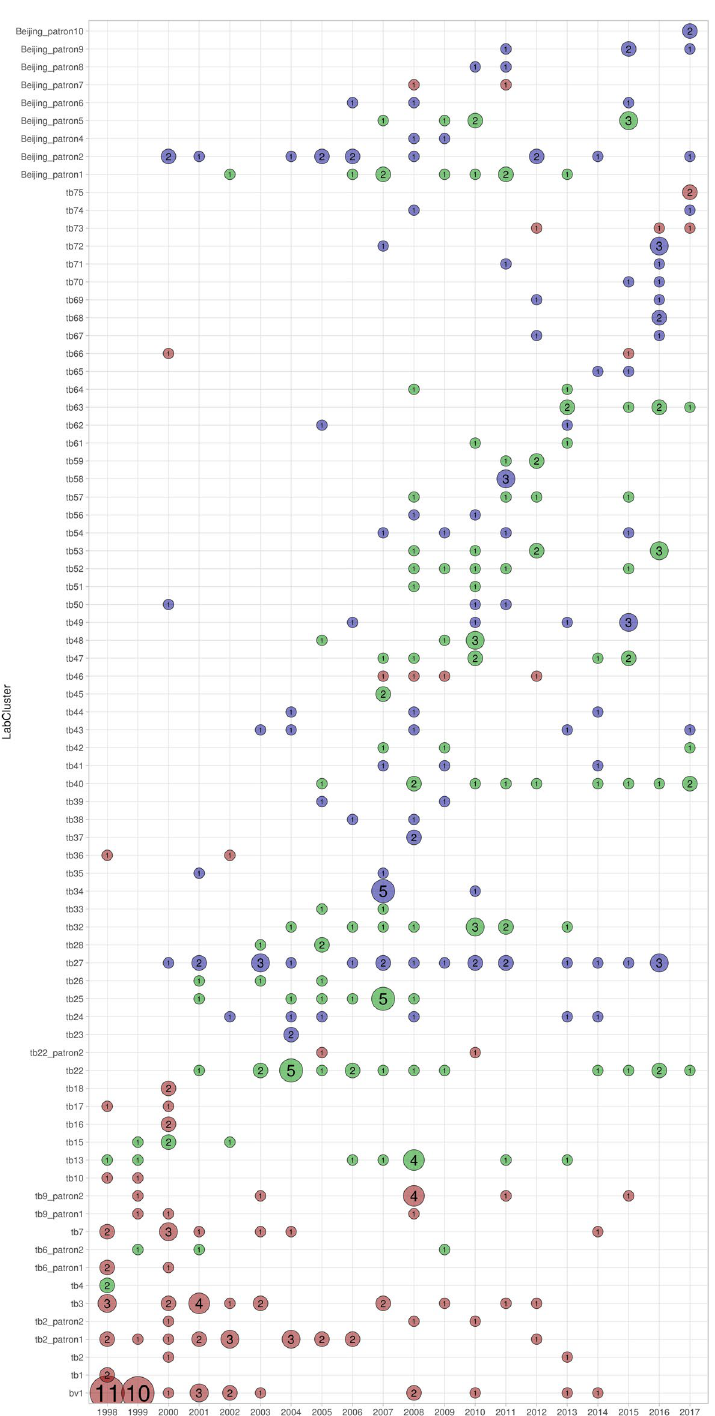
Figure 4. Distribution of the cases in clusters along the period studied. Red circles represent the native clusters, blue circles show foreign clusters and green circles show mixed clusters. The size of the circles is proportional to the number of the included